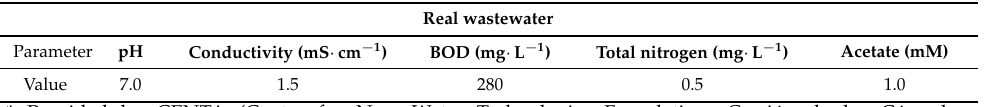
Table 2. Wastewater characteristics from the anaerobic lagoon of CENTA treatment plant *. Chemical oxygen demand: COD, biological oxygen demand: